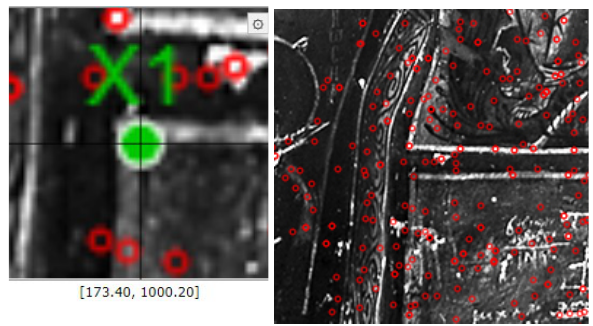
Figure 6. Image coordinates of feature point measured with WebPlotDigitizer tool and added in COLMAP.